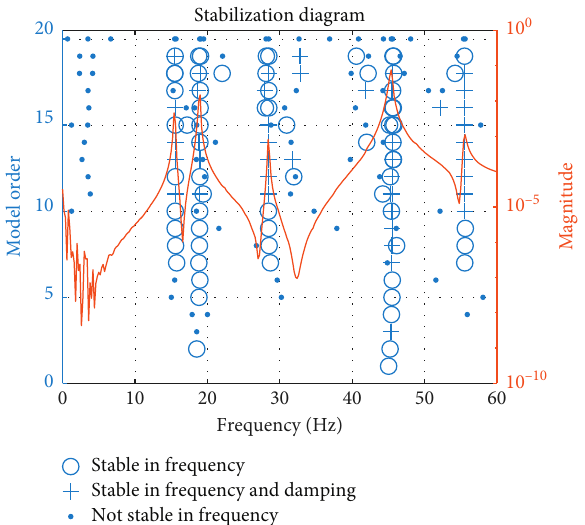
Figure 19: Stabilization diagram utilizing PolyMAX identification in the frequency